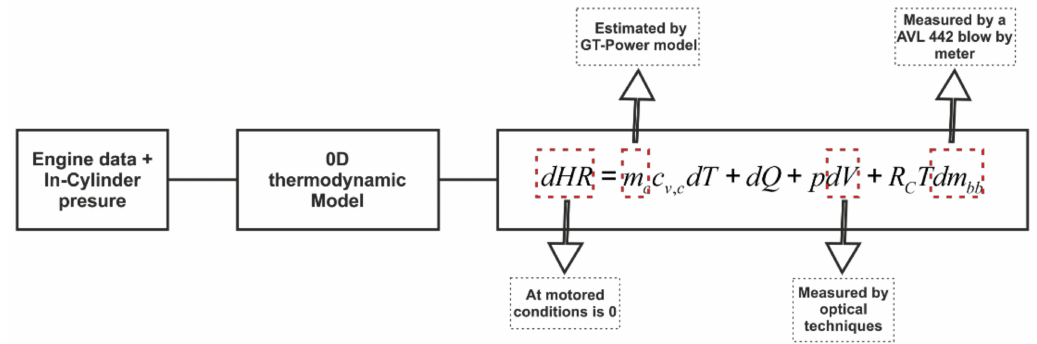
Figure 4. Scheme of the thermodynamic characterization